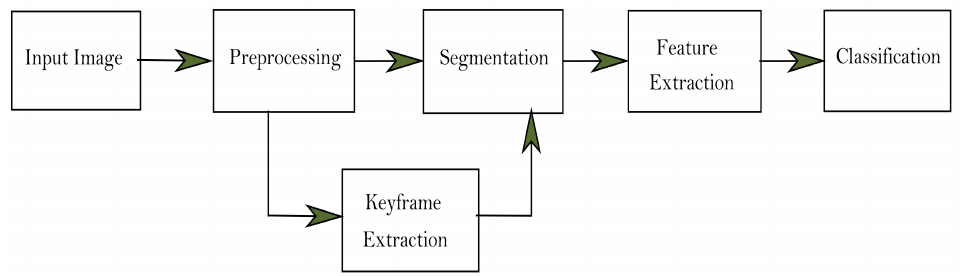
Figure 2. Flowchart of steps involved in diagnosis of